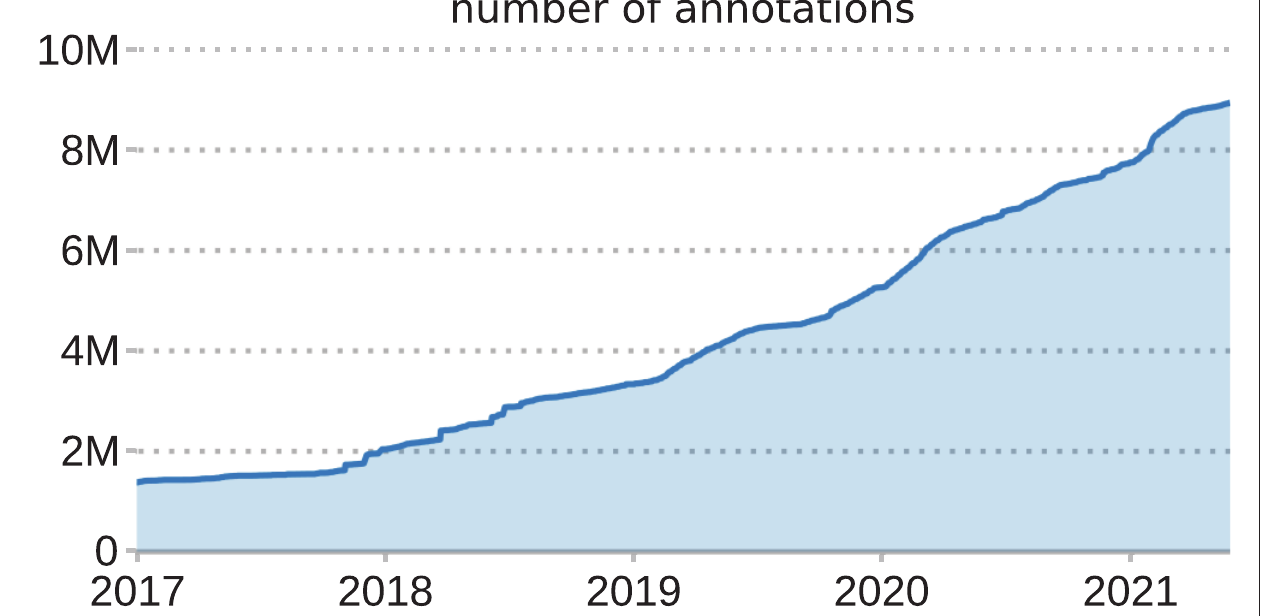
FIGURE 1 | Development of the number of users (top) as well as image and video annotations (bottom) in the BIIGLE instance at biigle.de since 2017. The dotted line represents the number of users with at least one image and/or video annotation.